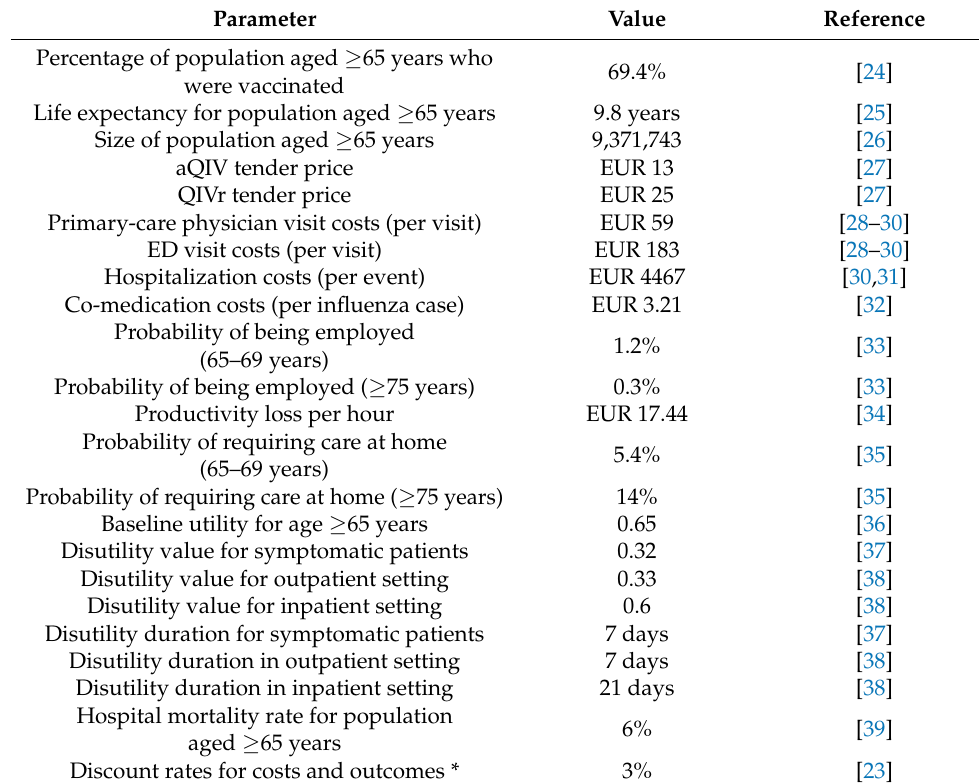
Table 2. Summary of parameters used as inputs for the